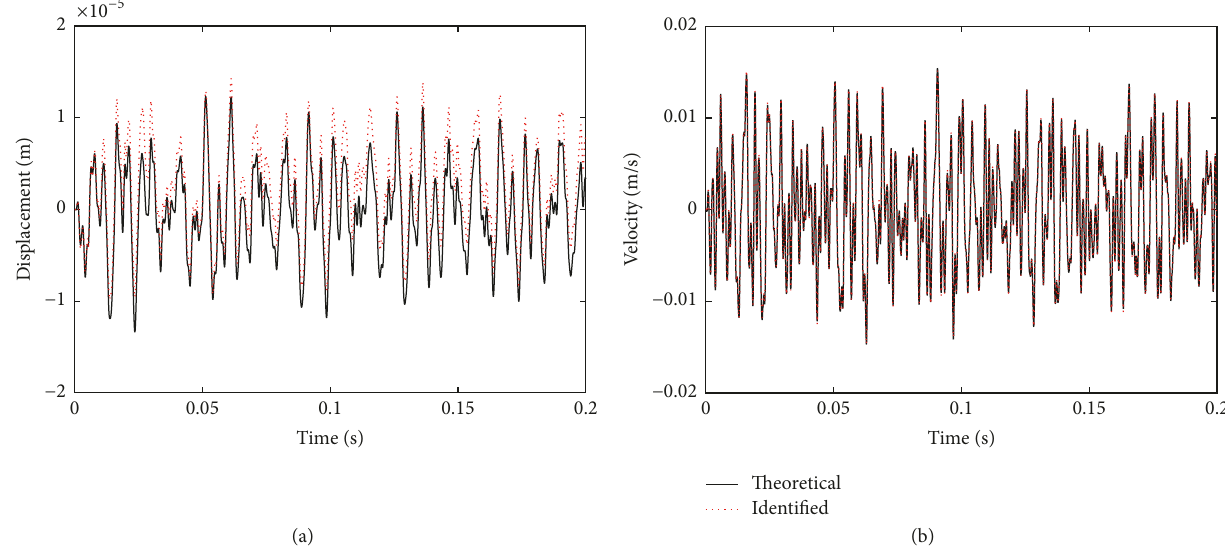
Figure 13: (a) The theoretical and identified vertical displacement at Node 70. (b) The theoretical and identified vertical velocity at Node 70.